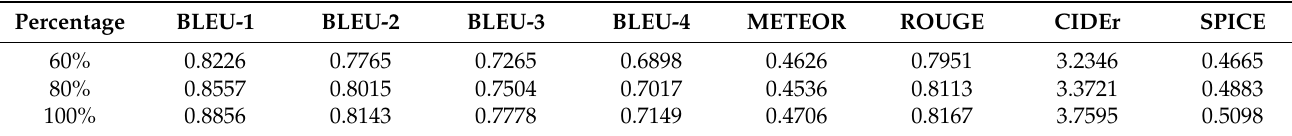
Table 4. Percentage sampling experimental results on UCM-Captions dataset.